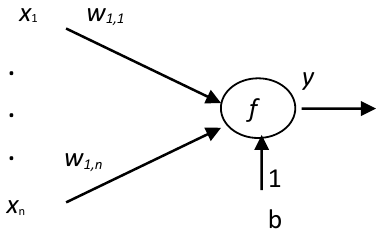
Figure 1. Model of a multi-input